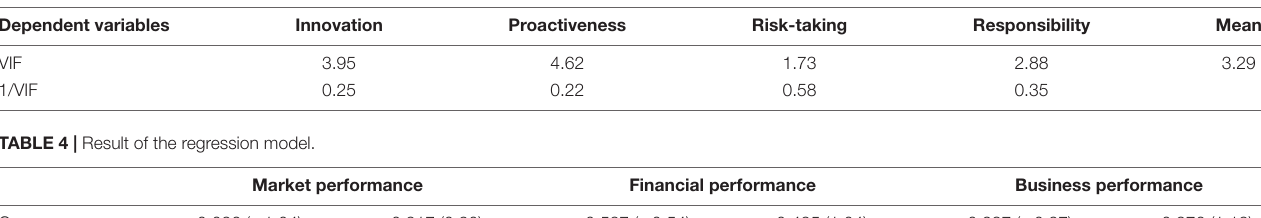
FIGURE 4 | Standardized path coefficient and load factor of structural equation. *** P < 0.001. TABLE 3 | Results of variance inflation factor (VIF) of dependent variables.